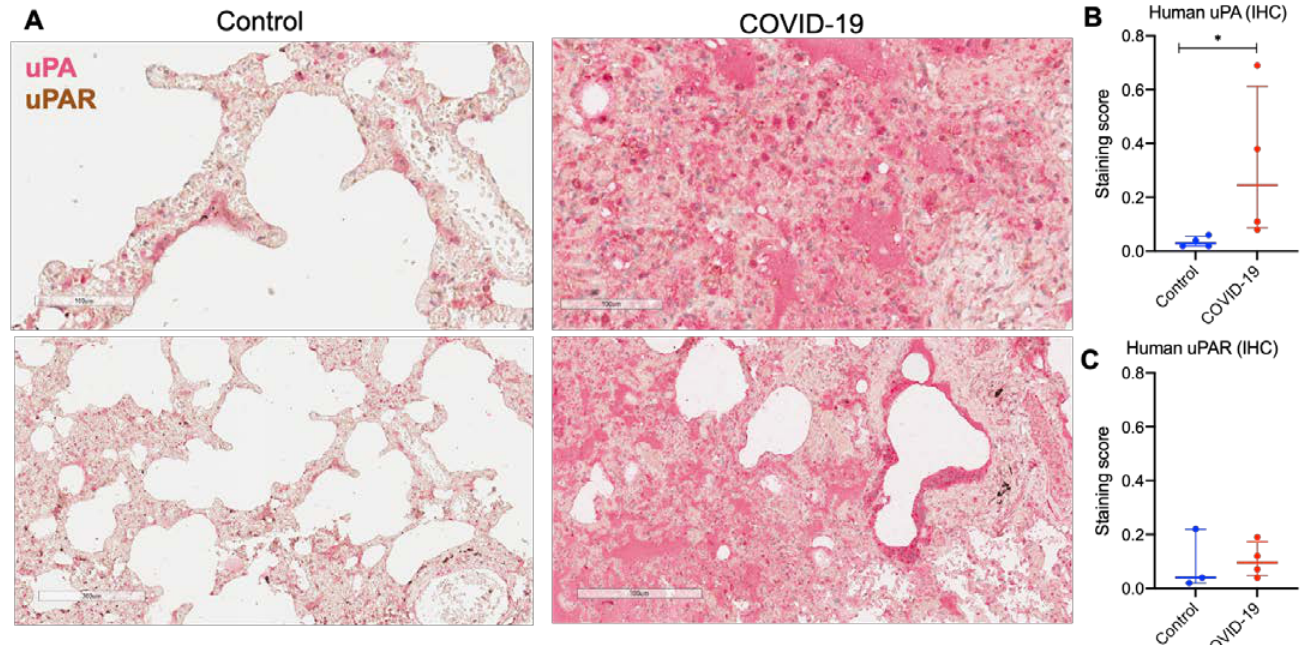
Figure 4. uPA and uPAR immunoreactive cells were detected in lung tissue of COVID-19 patients. ( A ) Representative sections of parenchymal tissue from COVID-19 patients and control healthy donors. uPA and uPAR were stained and revealed with ImmPACT Vector Red Substrate (uPA, pink) and DAB HRP Substrate (uPAR, brown). Scale bars—100 μm (upper panels) and 300 μm (lower panels). ( B ) uPA and ( C ) uPAR staining scores in the images of lung tissue sections of COVID-19 patients and control healthy donors. Images were analyzed using the Positive Pixel Count v9 algorithm of ImageScope (Aperio), which counts pixels of predetermined color (pink for uPA and brown for uPAR, positive pixels) and pixels related to other colors (negative pixels). A staining score was calculated as the number of positive pixels/(number of positive + negative pixels). Data are presented as median and interquartile range. * p < 0.05, Mann–Whitney test.